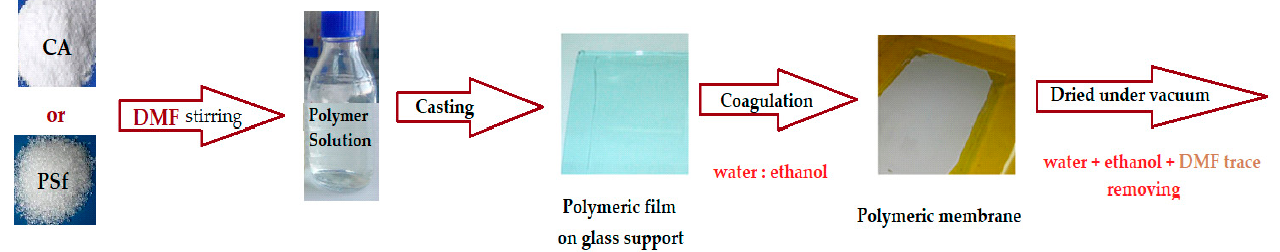
Figure 2. Schematic representation of the procedure for obtaining polymer membranes.